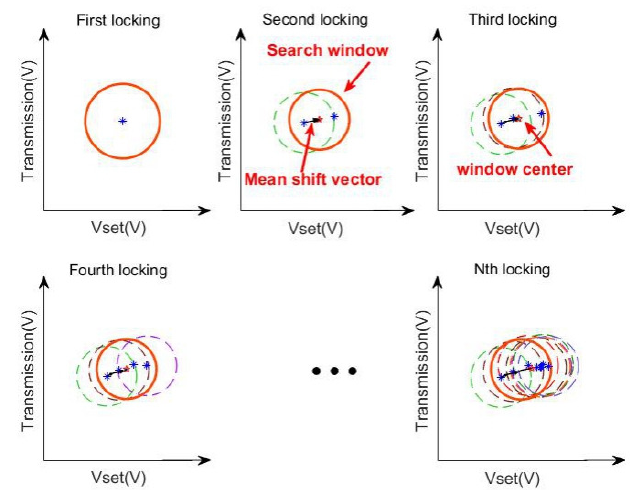
Figure 3. Improved mean shift algorithm for the scanning transmission